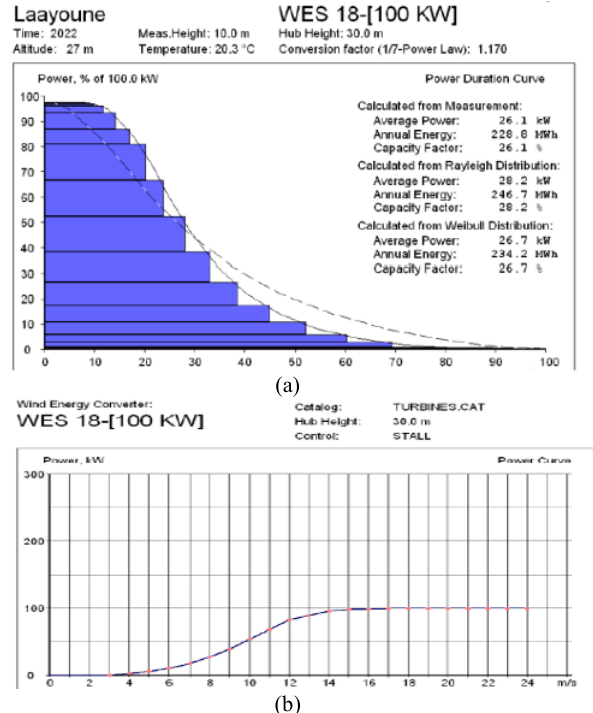
Table 5. Principal characteristics of the wind turbines Fig. 5. (a) and (b) Annual production for the turbine WES 18-100KW calculated by ALWIN. characteristics WES 18 XANT M- NPS 21 21 Hub Height (m) 30 31.8 29 100 100 100 Nominal power KW Rotor diameter 18